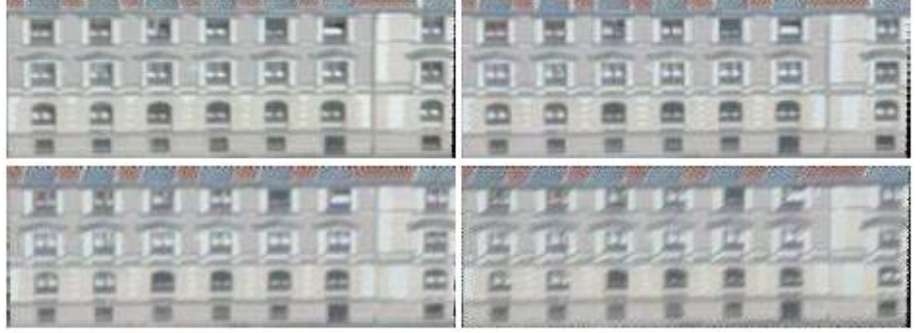
Figure 13. From a single facade of the building in Figure 11, one will obtain multiple segments of vertical aerial images. These have been rectified into a facade coordinate system. From an aerial image block showing typically 10 images for each object point, not all will contain useful data for a specific vertical facade. Selected here are the four best, where ―best‖ is defined as the largest area of a facade quadrilateral projected into an image.